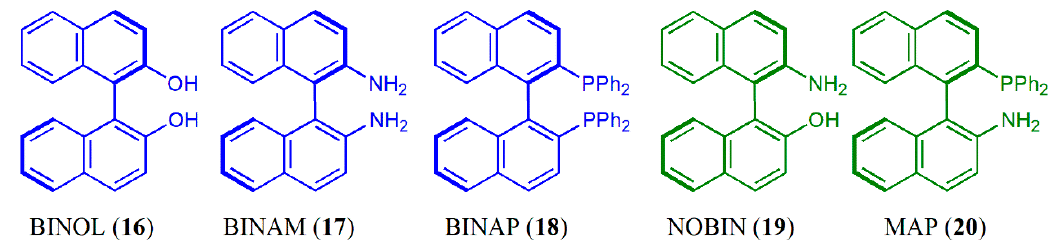
Figure 8. Axially chiral biaryls frequently utilized in synthesis and catalysis.